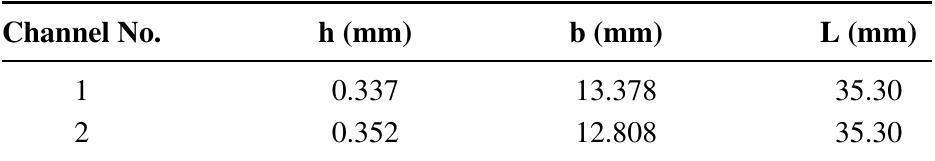
Table 1. Measured geometrical parameters of the